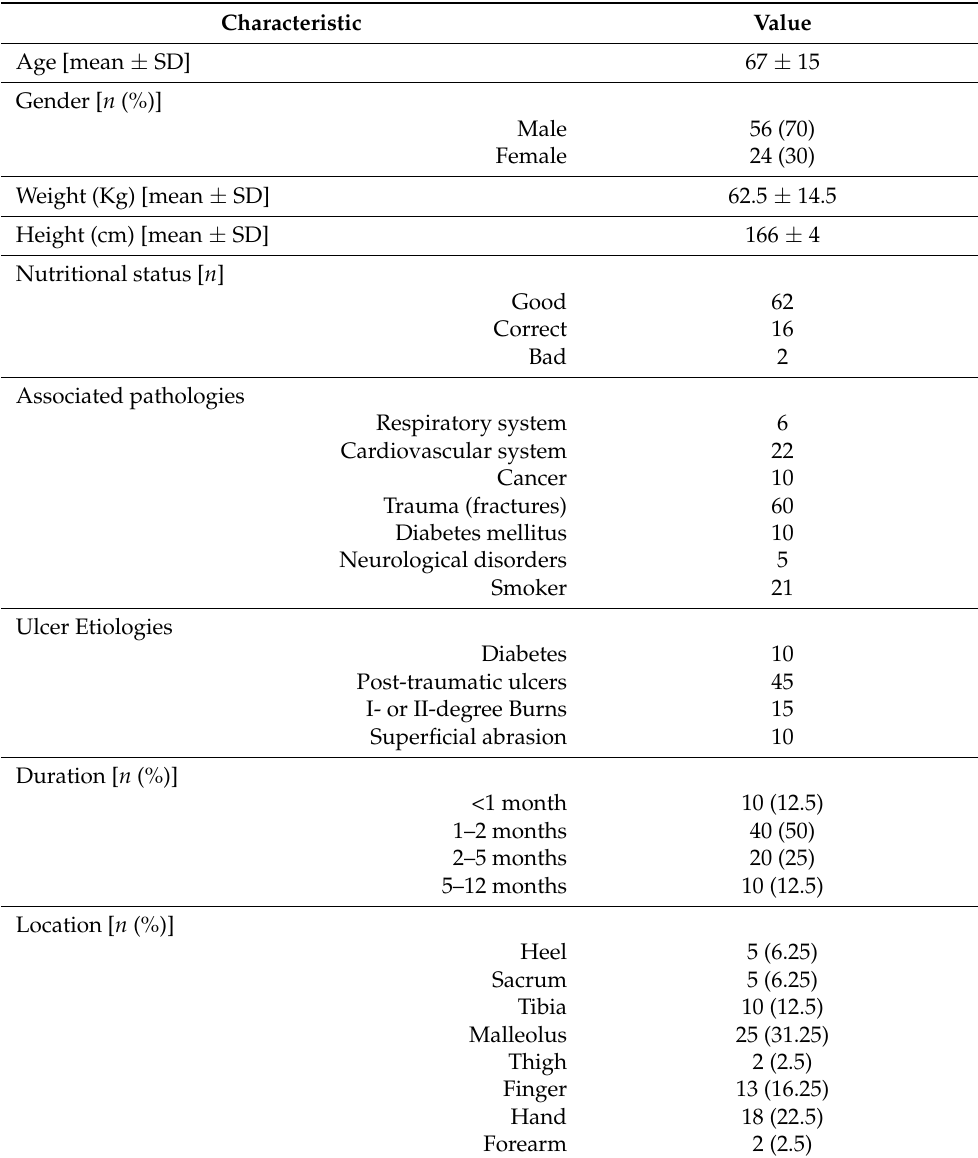
Table 1. Patient characteristics at inclusion ( n =